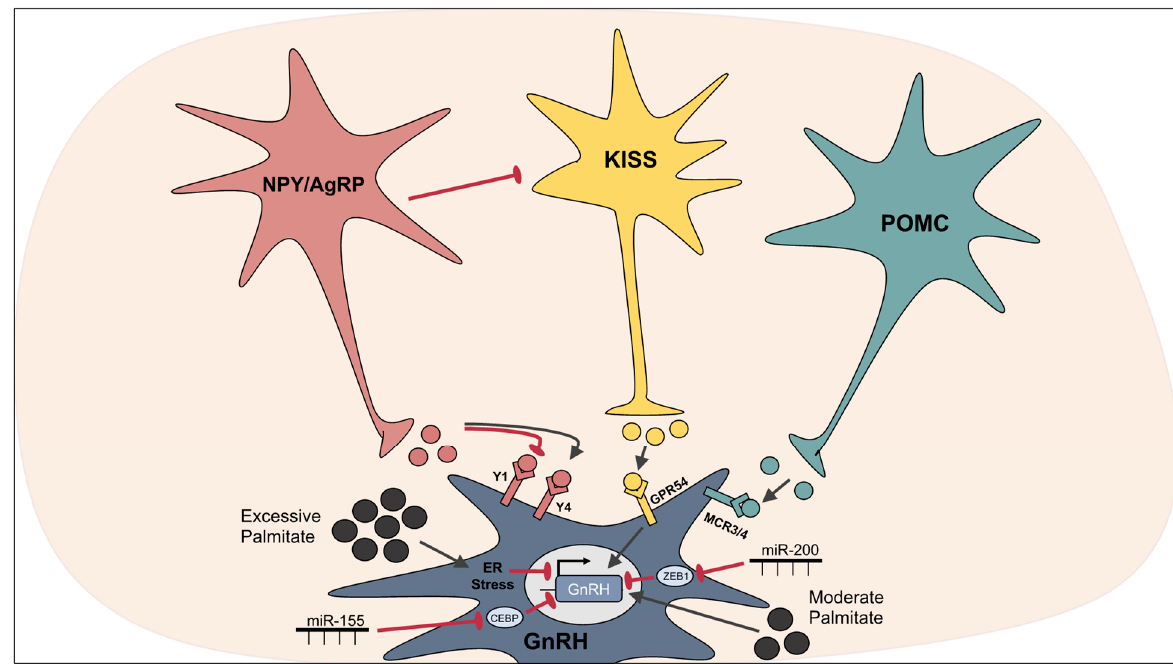
Figure 3. Regulation of GnRH neurons. NPY differentially affects GnRH neuron excitability depending on receptor variant availability; activation of Y1 is inhibitory and Y4 is excitatory. AgRP indirectly affects GnRH neurons by inhibiting afferent KISS1 neurons. KISS1 neurons secrete KISS1 which activates GPR54/KISS1r on GnRH neurons, leading to increased excitability and GnRH transcription. POMC neurons secrete α -MSH, which acts via MC3R and MC4R to increase GnRH neuron excitability. Moderate concentrations of palmitate induce Gnrh transcription, whereas high concentrations of palmitate induce ER stress and inhibit Gnrh transcription. miR-155 and miR-200 increase Gnrh mRNA by targeting Gnrh repressors CEBP and ZEB1, respectively.